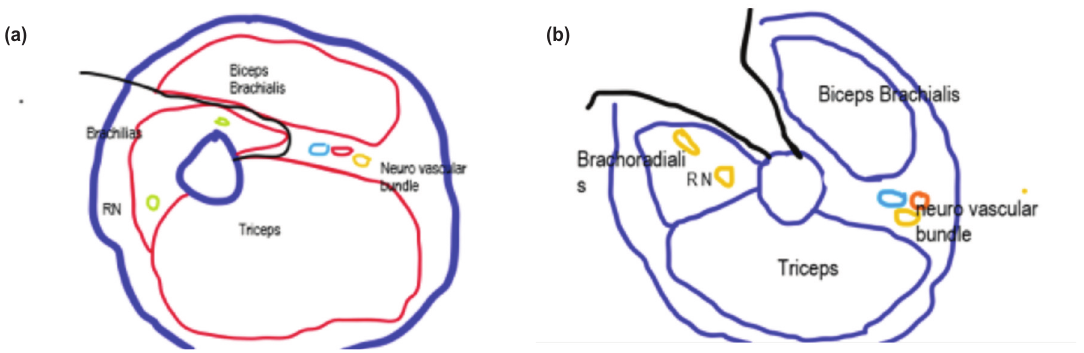
*black line indicate line of (a,b) Diagrammatic presentation of sub brachialis approach for medial humerus plating. Fig. 2: